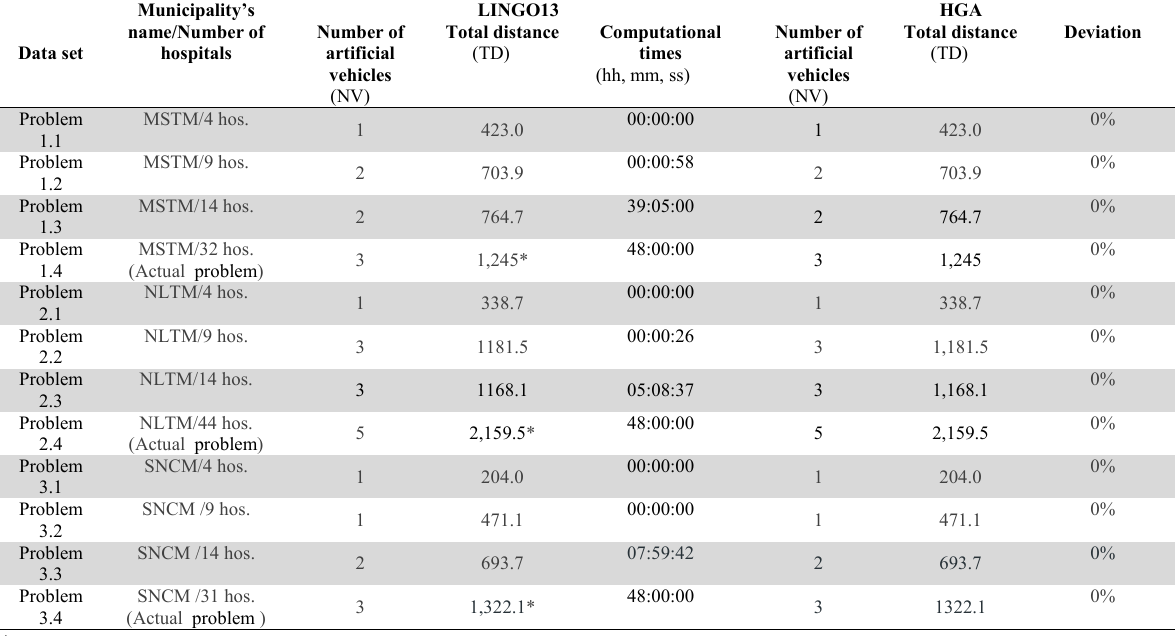
Comparison of solutions using LINGO13 and